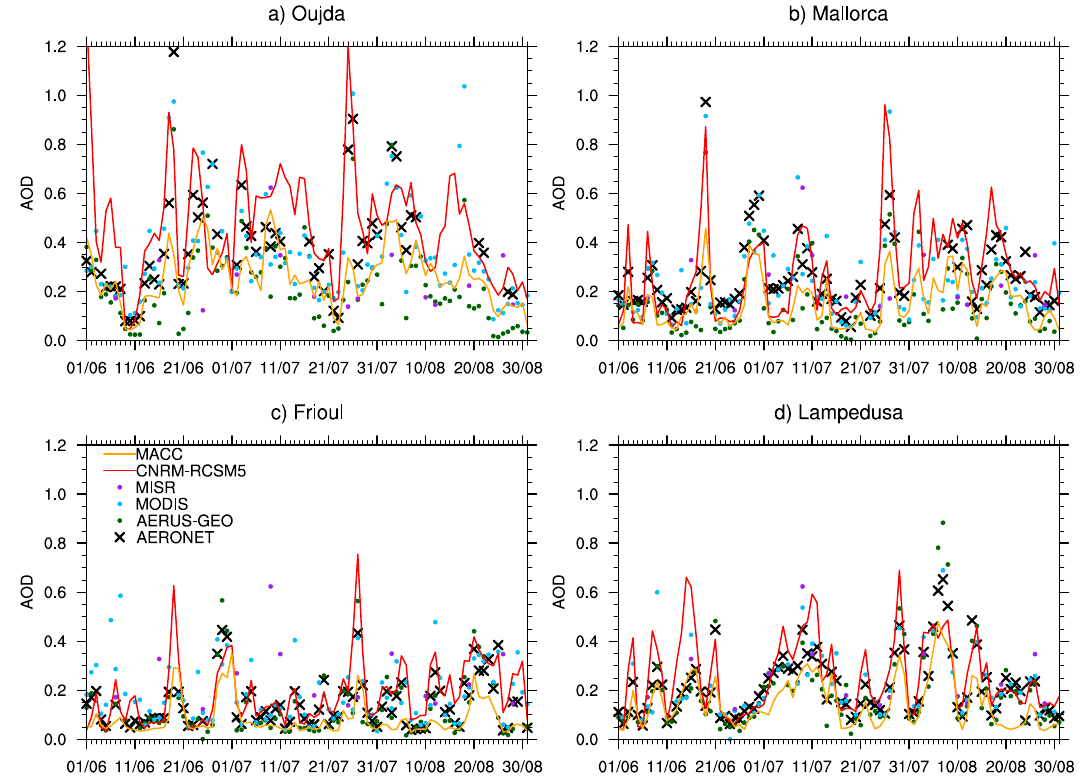
Figure 3. AOD (at 550nm) temporal series between 1 June and 31 August 2012 simulated by CNRM-RCSM5 (red lines) and MACC (orange Fig. 3. AOD (at 550 nm) temporal series between 1st June and 31st August 2012 simulated by CNRM-RCSM5 (red lines) and MACC lines) and observed by AERONET sun photometers (black crosses), MODIS (blue points) , MISR (purple points) and AERUS-GEO (green (orange lines), and observed by AERONET sunphotometers (black crosses), MODIS (blue crosses) and AERUS-GEO (green crosses), at points) at four stations of the AERONET network: Oujda ( a , number 10 in Fig. 1), Mallorca ( b , 2), Frioul ( c , 8) and Lampedusa ( d , four stations of the AERONET network: Oujda (a, number 10 in Figure 1), Mallorca (b, 2), Frioul (c, 8) and Lampedusa (d, 1).